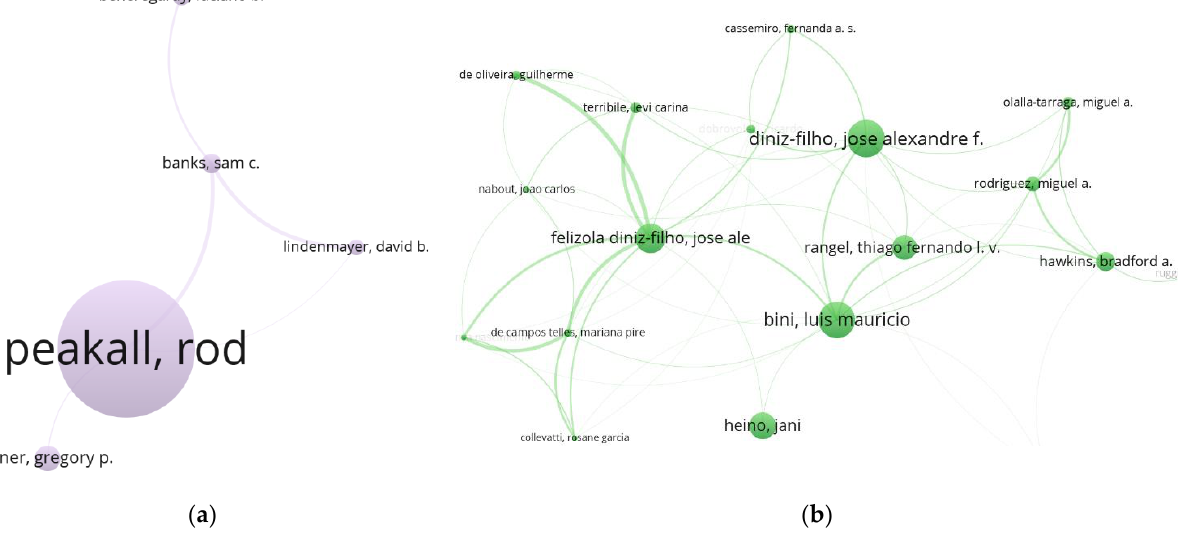
Figure 4. Two research communities in the Southern Hemisphere: ( a ) Peakall’s GenAIEx community (Peakall, 139.71); ( b ) Diniz–Bini–Rangel community (Note: the node “diniz-filho” and the node “felizola diniz-filho” should be combined into one node. Diniz, 39.18 (=21.82 + 17.36); Bini, 21.46; Rangel, 14.36.)